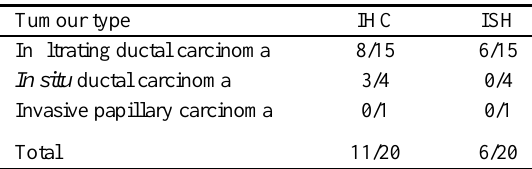
Detection of c-erbB-2 mRNA and oncoprotein by ISH and IHC methods in 20 cases of human breast